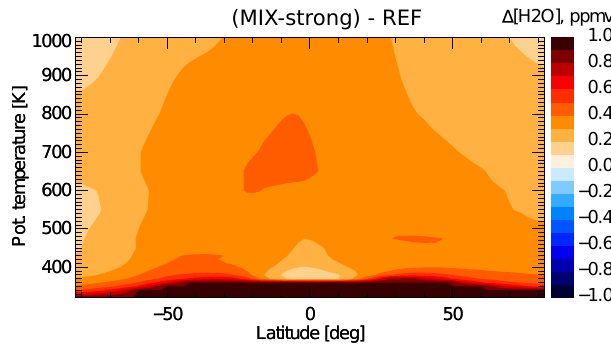
Figure A2. Differences of zonal mean water vapour from CLaMS sensitivity simulations with non-vanishing mixing strength between reference (REF) and strong mixing (MIX-strong) cases averaged over the period from 2011 to